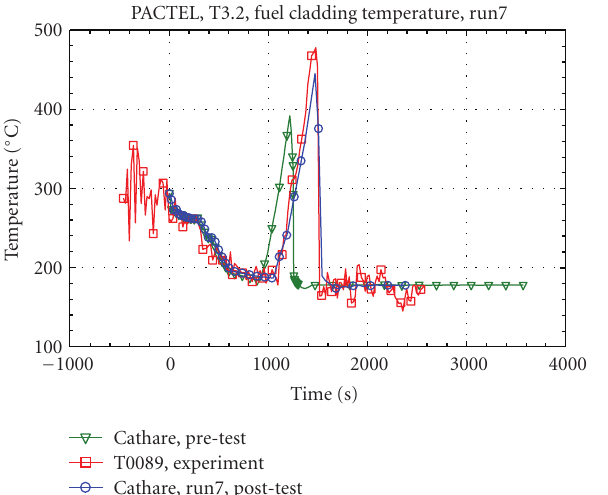
Figure 14: Fuel cladding